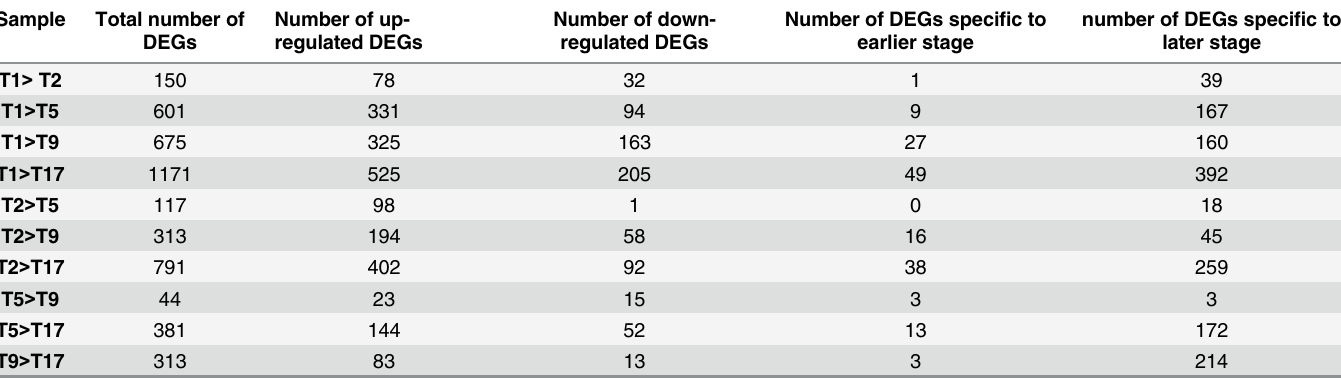
Table 3. Statistics of differentially expressed genes among